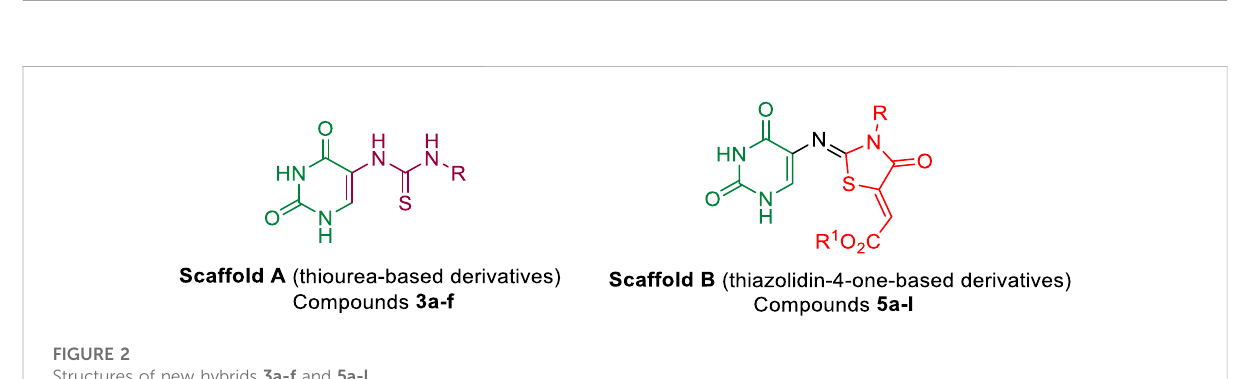
FIGURE 2 Structures of new hybrids 3a-f and 5a-l